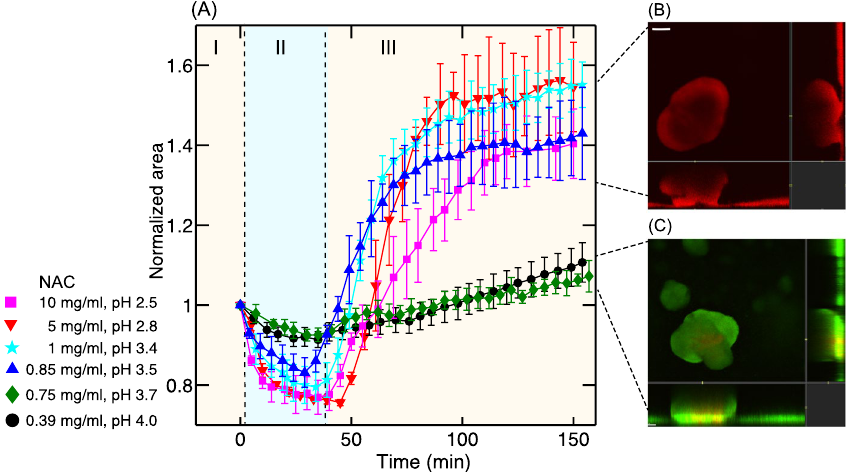
Figure 3. ( A ) Normalized area of microcolonies versus time when treated with different concentrations of NAC. Shrinkage of colonies during treatment (region II) and swelling after treatment (region III) occurs at NAC concentrations greater than 0.85 mg/ml at which the pH < 3.5. For concentrations less than 0.85 mg/ml (pH > 3.5), a gradual increase in size of the microcolonies (region III) indicates the growth of the microcolonies over time due to the presence of live bacteria. ( B ) A representative confocal image of the colonies in which swelling has taken place and ( C ) no swelling (other than due to live bacteria growth) has taken place. The images display green and red channels and correspond to the 100 min time